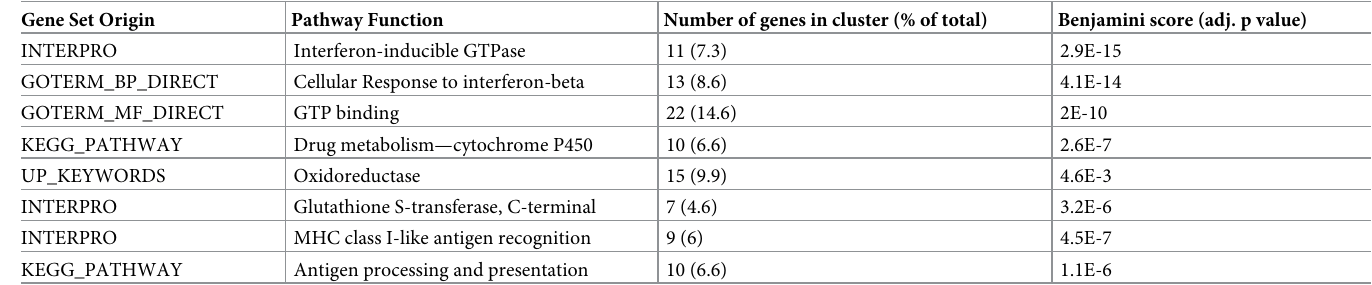
Table 1. Gene pathways enriched in IFN γ -R+/+